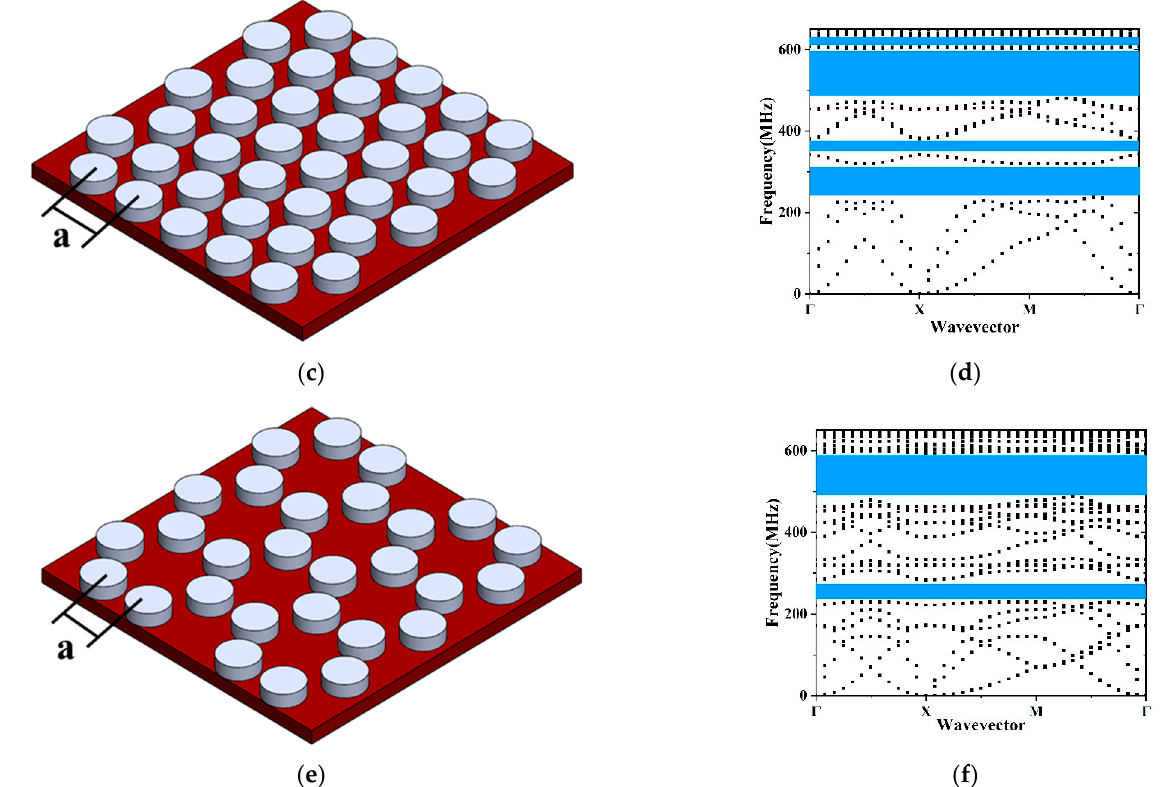
Figure 4. The schematics for ( a ) honeycomb, ( b ) hexagonal, ( c ) square lattice. The dispersion curves of PnC slabs with ( d ) honeycomb, ( e ) hexagonal, ( f ) square lattice.